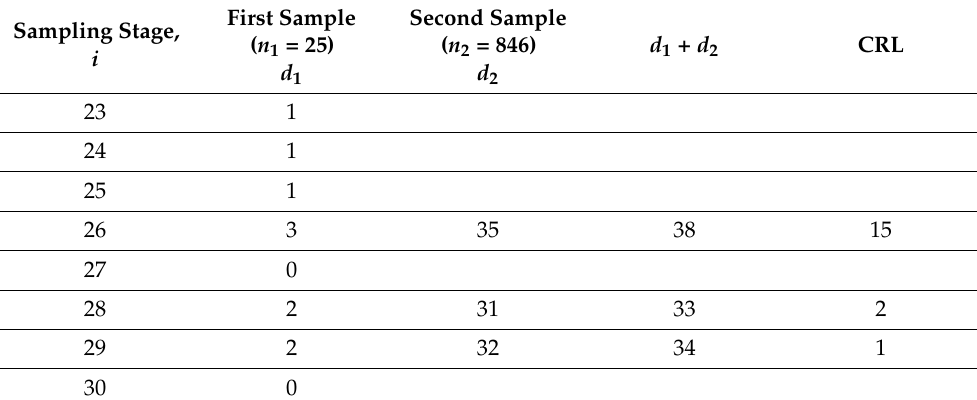
( b ) Figure 5. ( a ) DS np sub-chart of the SDS np chart for minimizing EMRL 1 . ( b ) CRL sub-chart of the SDS np chart for minimizing EMRL 1 . The process of taking the first sample and likely the second, for each sampling stages is continued until sampling stage i = 26, here d 1 + d 2 = 38 is seen for d 1 = 3 ( W < d 1 < L 1 ) and d 2 = 35. Hence, sampling stage i = 26 is categorised as nonconforming because d 1 + d 2 > L 2 . The nonconforming sampling stages are also seen at sampling stages i = 28 and 29. This leaves the nonconforming sampling stages of i = 11, 26, 28, and 29 as OOC states. 7. Conclusions This study investigates the MRL and EMRL performances of the SDS control chart for detecting increasing shifts in process fraction nonconforming. When compared to ARL, MRL is a better performance criterion to use. It is demonstrated that the claims for its superior performance over the synthetic np and DS np charts are based on the fact that ZS mode has a hidden feature that gives it a head-start. However, for the majority of SPC applications, it is more crucial to assess the control chart’s statistical performance after a prolonged time of IC operation (i.e., when the process is in SS mode), when it is necessary to detect a shift in the process. It has been discussed how to employ the Markov chain to